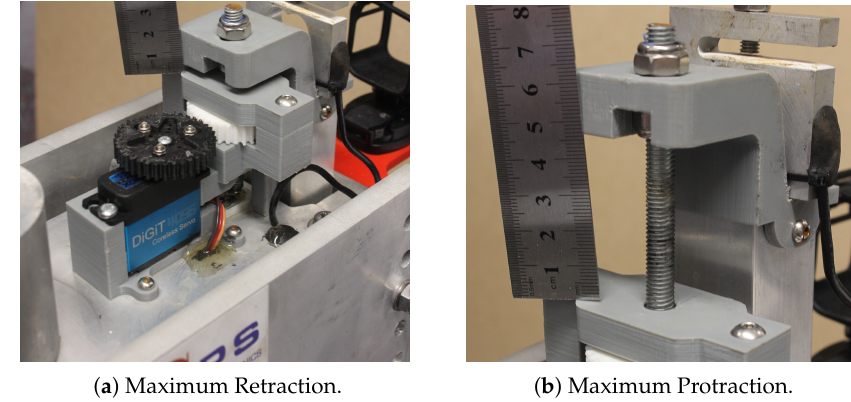
Figure 2. Photographs of penetrometer extremes.